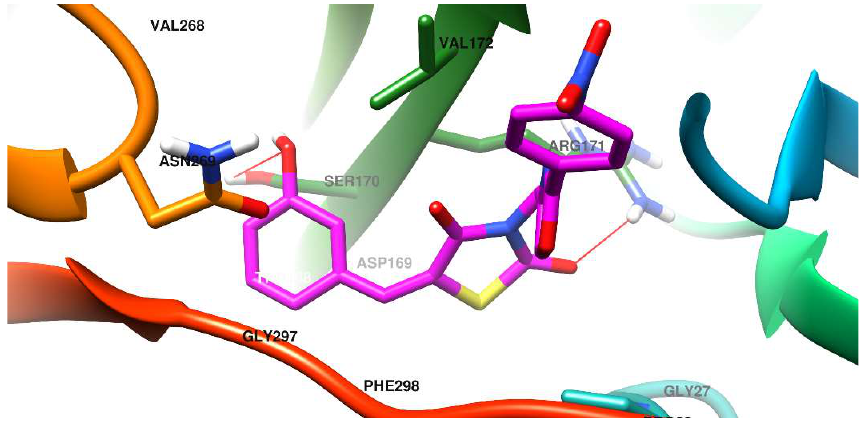
Figure 5. Compound 5d docked in the binding site of the C. albicans Als3 surface protein.